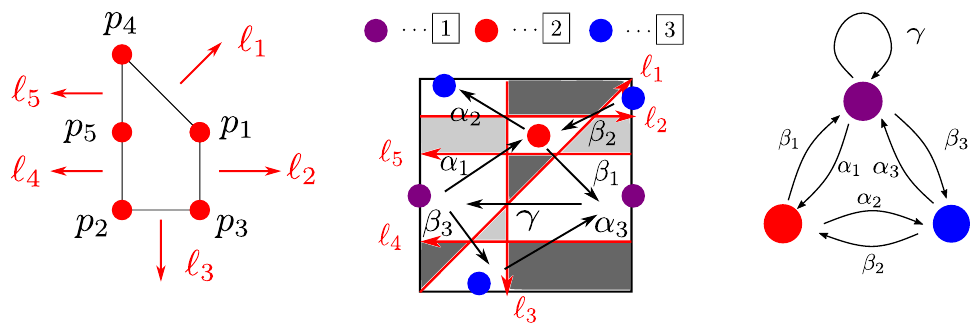
Figure 31. Toric diagram, periodic quiver, and quiver diagram of the suspended pinch point geometry. The lattice points of the toric diagram are p and p = (0 , 1) . The external legs are denoted as ‘ 5